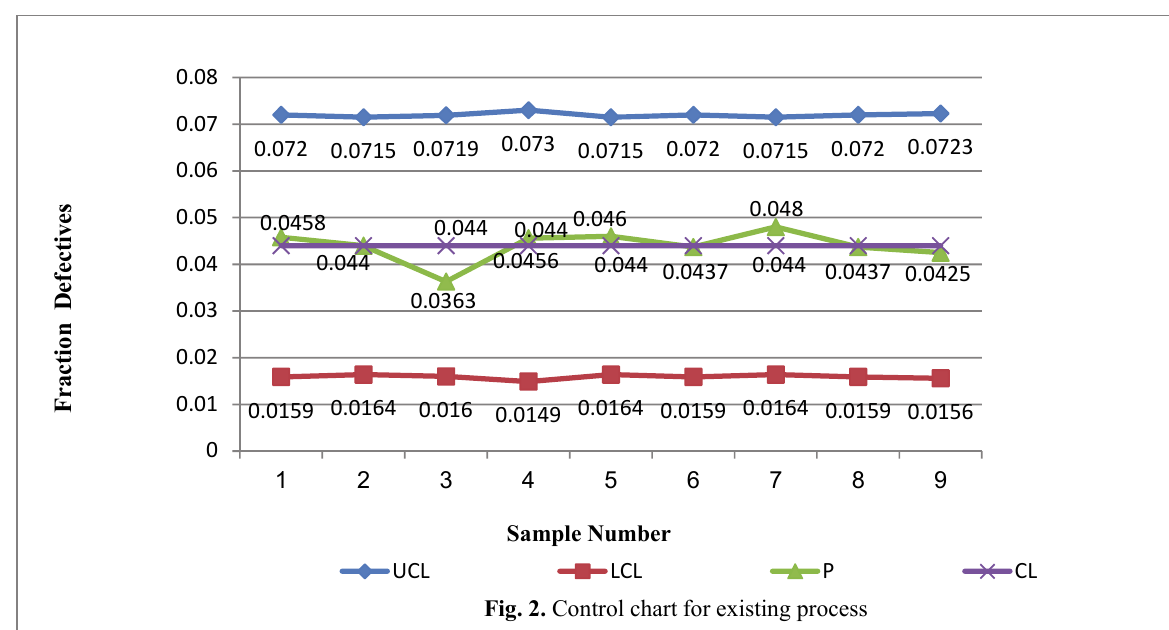
Fig. 2. Control chart for existing